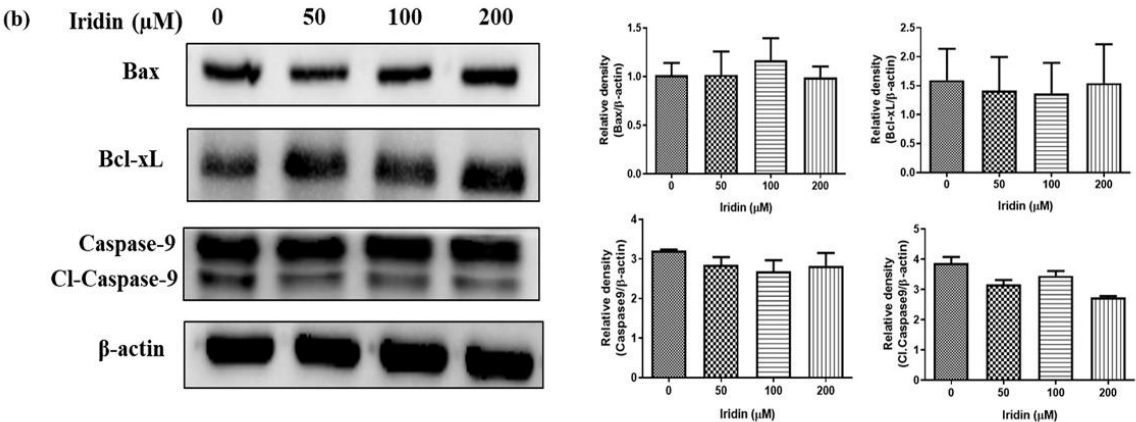
Figure 4. Iridin induces an extrinsic apoptotic pathway in AGS cells. ( a ) The cells were treated with iridin at indicated concentrations (0, 50, 100, and 200 µ M) for 48 h. Total cell lysates were separated in sodium dodecyl sulfate (SDS)- polyacrylamide gels and blotted onto polyvinylidene difluoride (PVDF) membranes. The membranes were probed with Fas, FasL, caspase-8, cleaved caspase-8 (Cl-Caspase-8), and β -actin antibodies. ( b ) The cells were treated with iridin at indicated concentrations (0, 50, 100, and 200 µ M) for 48 h. Total cell lysates were separated in sodium dodecyl sulfate (SDS)-polyacrylamide gels and blotted onto polyvinylidene difluoride (PVDF) membranes. The membranes were treated with antibodies for Bcl-xL, Bax, Caspase-9, cleaved Caspase-9 (Cl-Caspase-9), and β -actin. Electrochemiluminescence (ECL) detection system used to visualize the proteins. Bar and error bar values represent the mean ± standard error of the mean (SEM) of three independent experiments. * p < 0.05 vs. control, ** p < 0.01 vs. control, *** p < 0.001 vs. control.